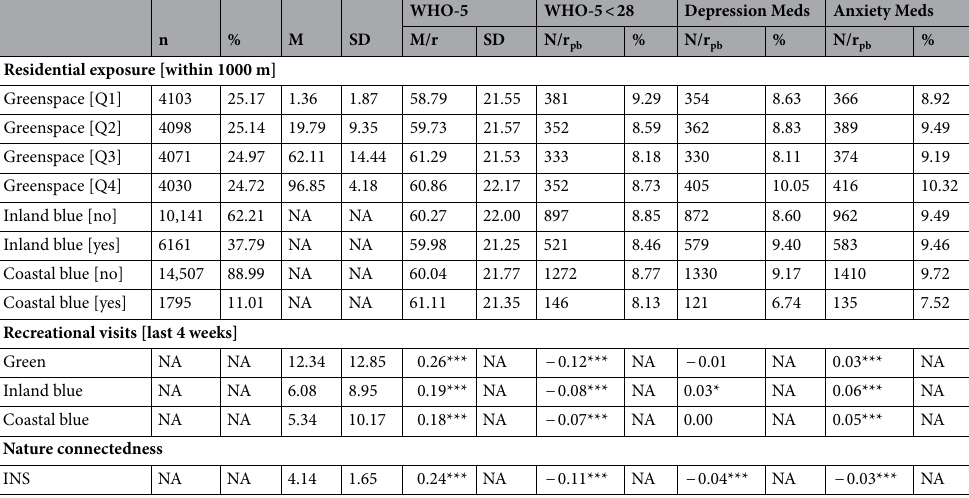
Table 1. The Ns, percentages (%), means (Ms), standard deviations (SDs), and correlations (r / r pb ) for the four mental health outcomes as a function of residential exposure (Q = quartile), recreational visits and nature connectedness for the analytical sample (n = 16,302). r Pearson’s correlation, r pb point bi-serial correlation (due to binary outcome); INS = inclusion of nature in self scale. *** p < 0.001; see Supplementary Table S1 for details of all